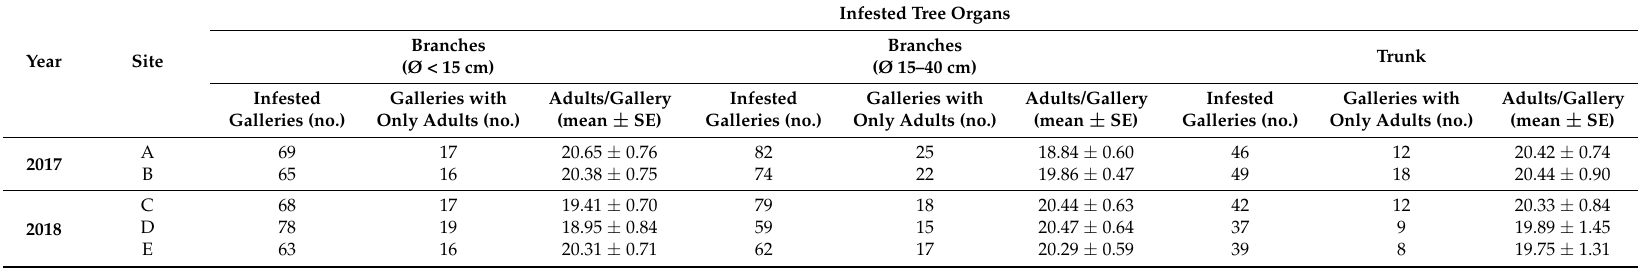
Table 2. Total number of infested galleries and mean number of Xylosandrus compactus adults/gallery (obtained from galleries with only adults) on different Carob tree organs in five sites in Sicily,